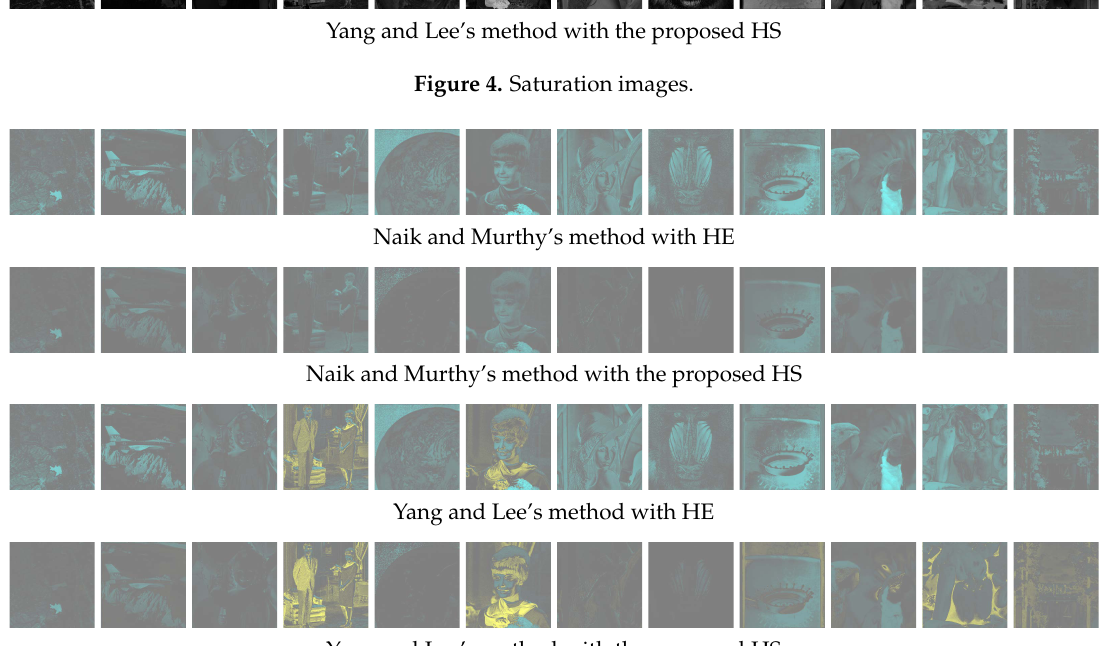
Figure 4. Saturation images.